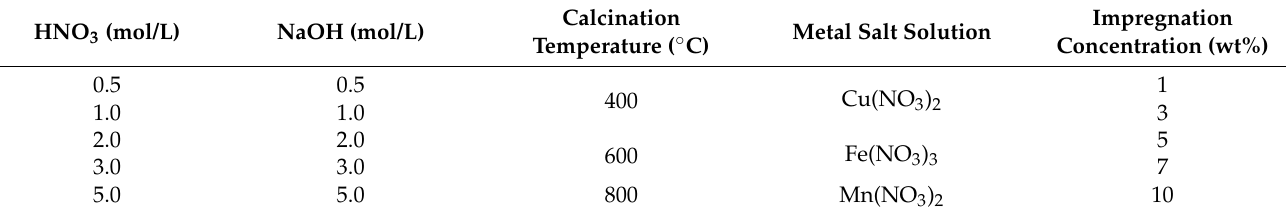
Table 1. Modification conditions for activated